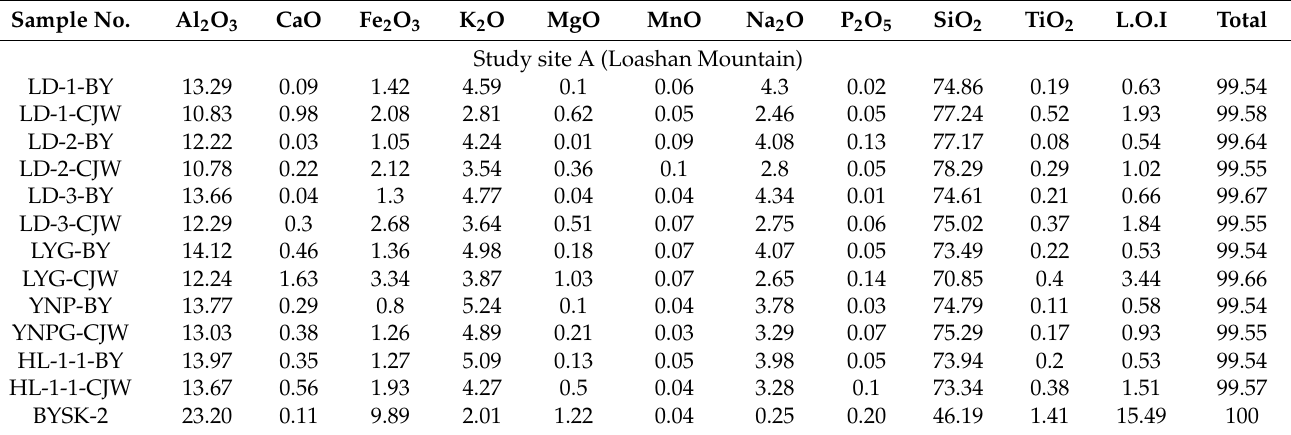
Table 1. Major element compositions for samples taken from the three study